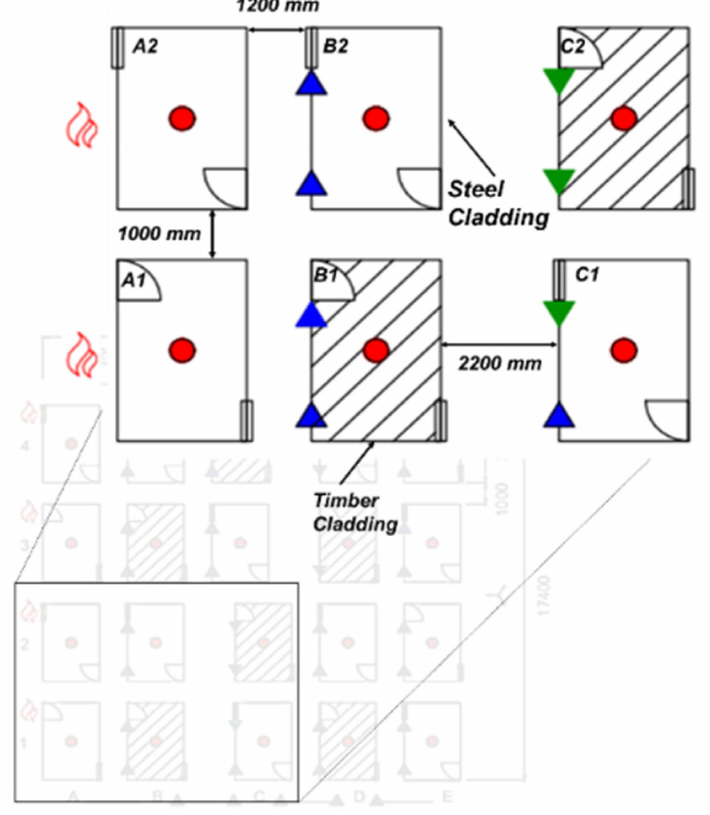
Figure 17. Section of 20 large-scale dwelling FSE on fire spread in ISDs considered for 6 Nos